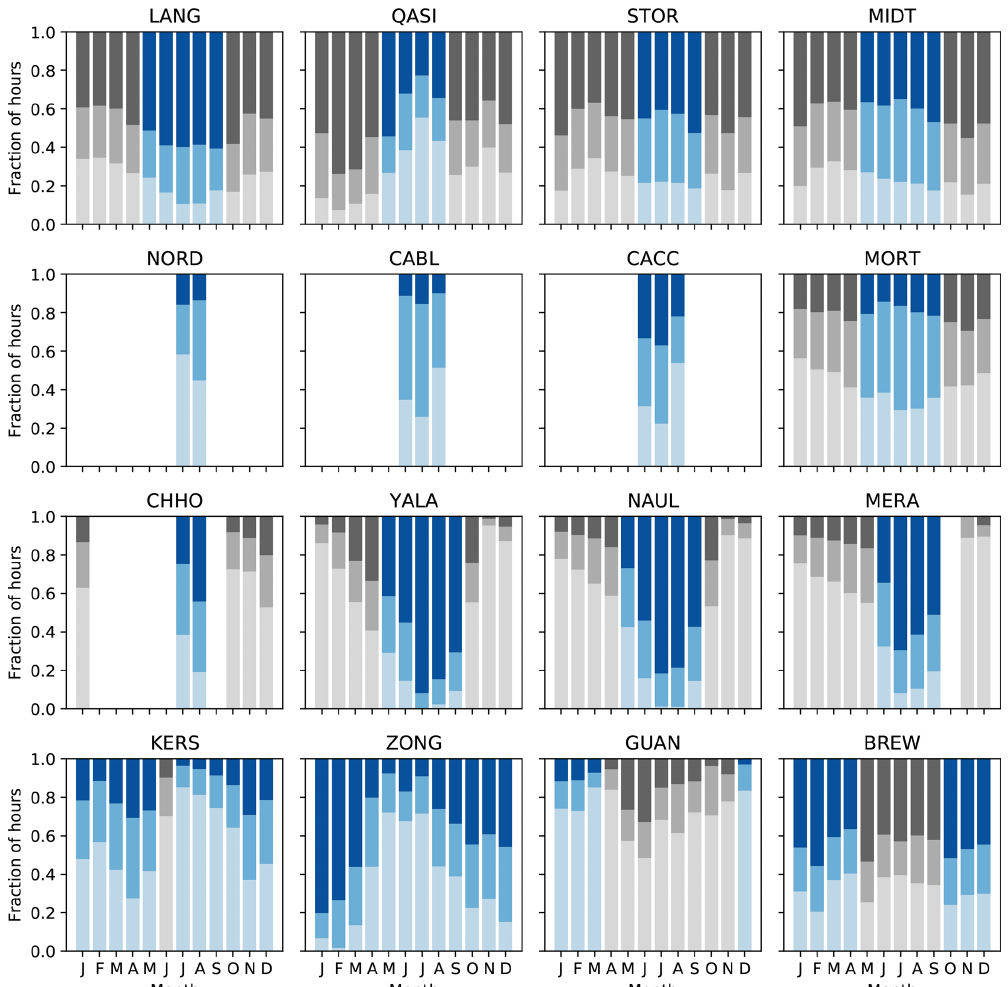
Figure A4. Monthly fraction of clear-sky (light shading), partially cloudy (mid shading) and overcast conditions (dark shading) defined using hourly cloudiness ( N ε ). Months defined as within the melt season are shaded